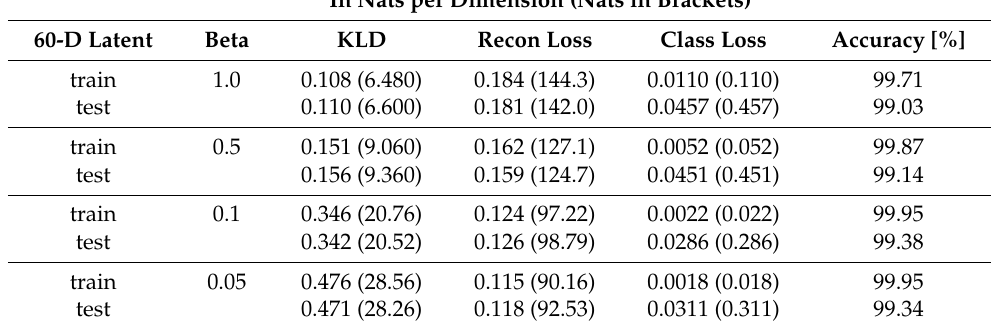
Table A2. Losses obtained for different β values for MNIST with a 60-D latent space. Training conducted in isolated fashion to quantitatively showcase the role of β . Un-normalized values in nats are reported in brackets for reference